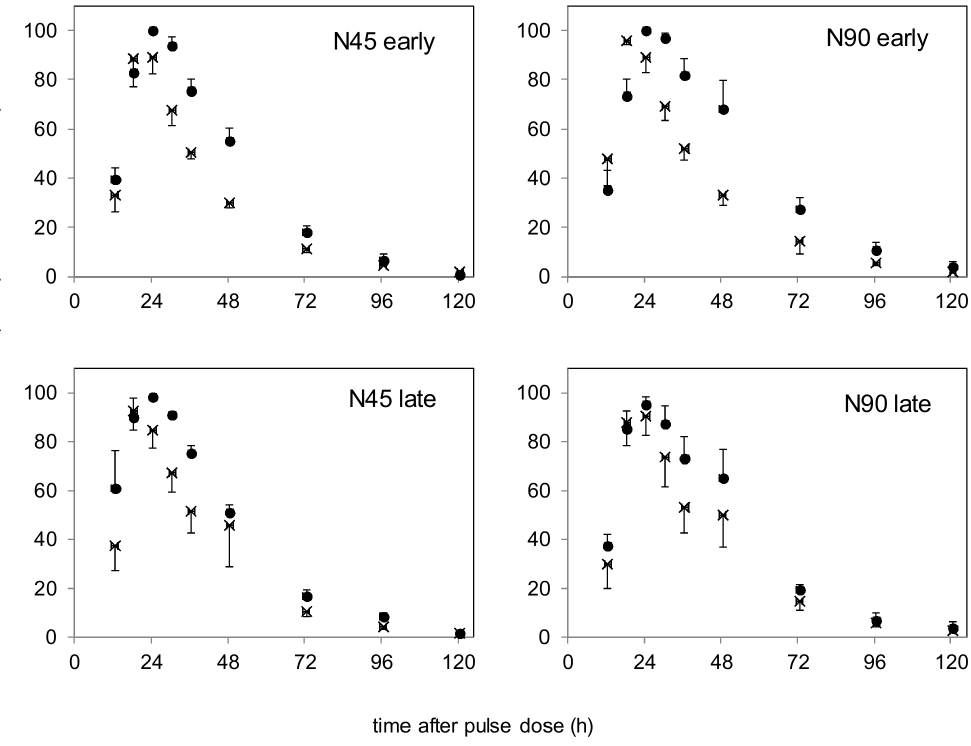
Figure 2. Fecal dilution curves of d 13 C labeled C 31 n -alkane ( (cid:3) ) and chromium mordanted fiber ( 6 ). Dilution curves show mean fecal tracer concentrations with standard error bars upon an intraruminal pulse dose in dairy cows fed grass silages of early and late maturity at two nitrogen (N) fertilization levels (N45:45 kg N/ha; N90:90 kg N/ha).